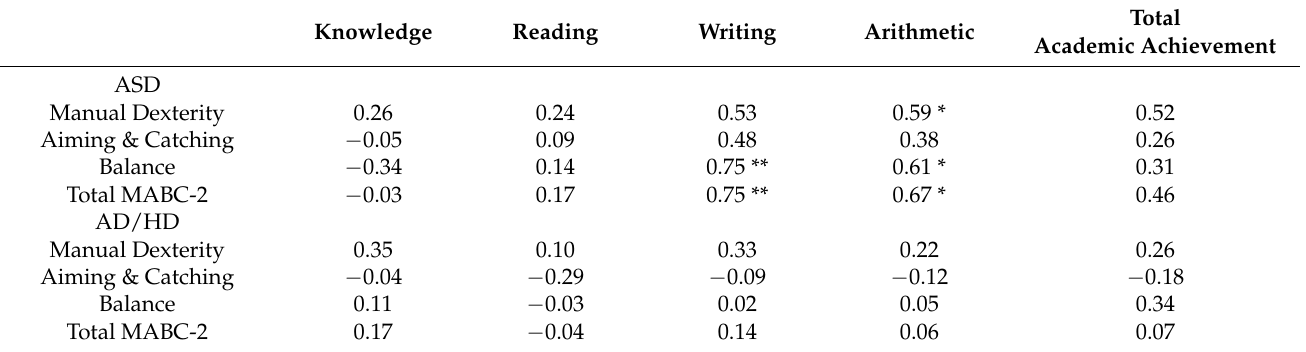
Table 4. Correlations between standard scores of the MABC-2 and academic achievement test of the